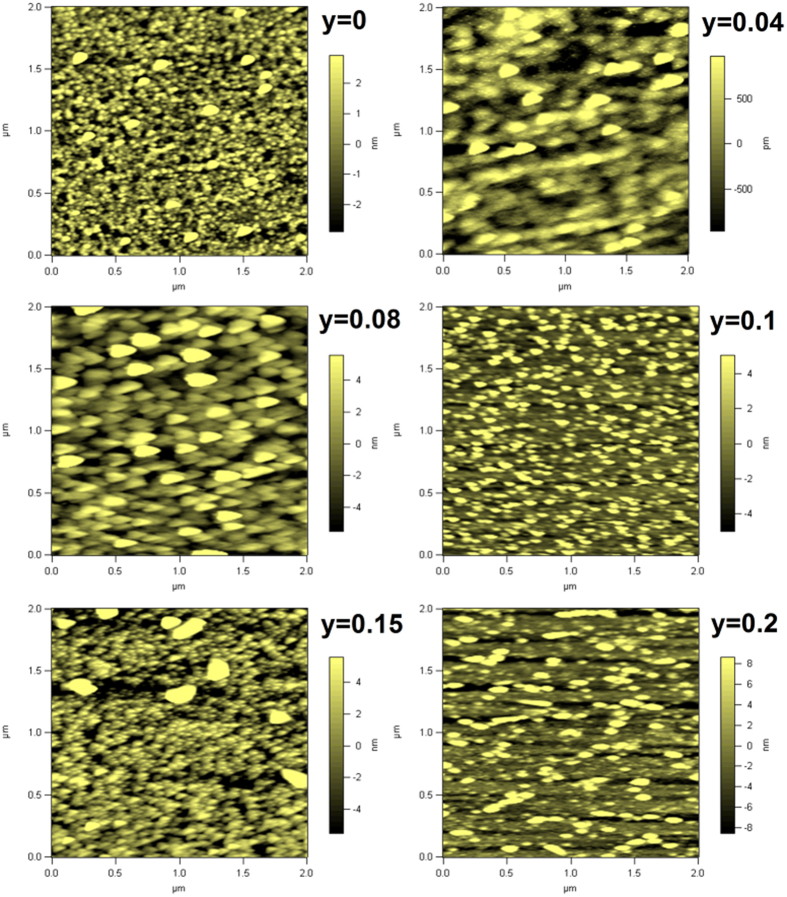
Atomic force microscopy images of the Sm0.5Sr0.5Mn1−yCryO3 films over 2 × 2 μm2 scan area.